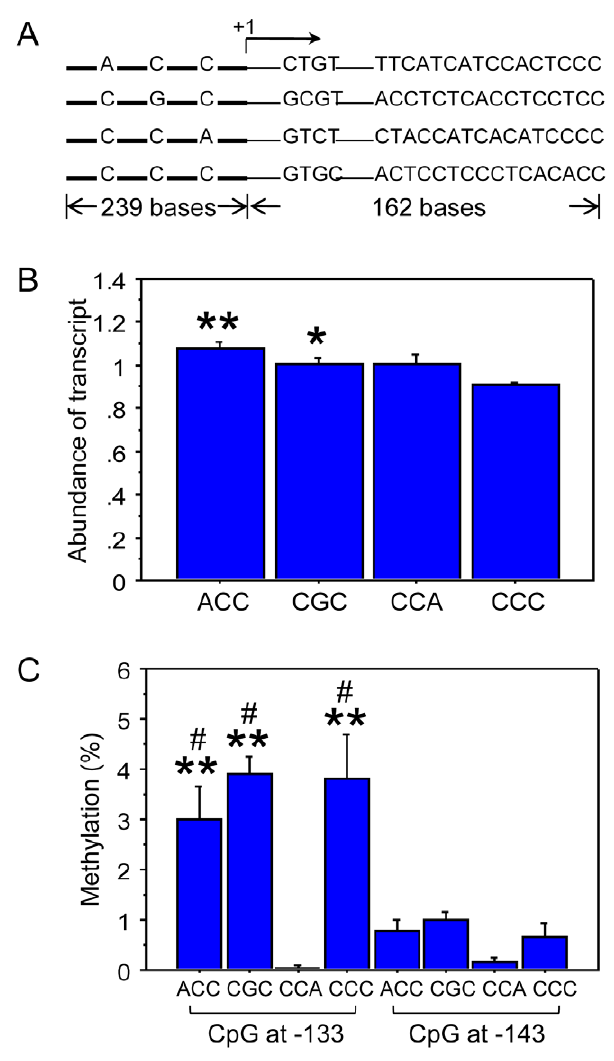
Figure 6. Haplotype-related rRNA transcription and rDNA methylation invitro . (A) Four haplotype constructs carrying unique SNPs in the rDNA promoter region (bold line) and tetranucleotide identifications in rRNA transcripts ( + 1: transcription start site). The differential 3 9 -end sequences provide priming sites for haplotype- specific enrichment. (B) The relative abundance of each haplotype transcript corrected by that of rDNA template (4 independent measurements, *p , 0.05, **p , 0.01 compared with the CCC, unpaired T test). (C) The level of methylation in each of 4 haplotypes from the same sample in in-vitro transcription assay after subtraction of background that was measured in originally unmethylated haplotype construct (4 independent measurements, **p , 0.01 compared with the CCA, # p , 0.05 compared with corresponding haplotype at the 2 143 CCA, or ggtgtgagggaggagtattg for CCC) and a common lower primer (accaattattcctttaaaatcc), were used to enrich individual haplotype from bisulfite-modified DNA with 7 cycles of PCR in separate reactions. A 1/100 dilution of PCR products was further amplified for 34 cycles using an upper primer (tggaagttatatttggg- gaggt for ACC, CGC, and CCC haplotype; tggaagttatatttgtggaggt for CCA) and the biotin-accaattattcctttaaaatcc lower primer. Pyrosequencing primer, tggtttaaaaatgattttat, was used to interrogate methylation at 2 133 and 2 143 CpG sites.